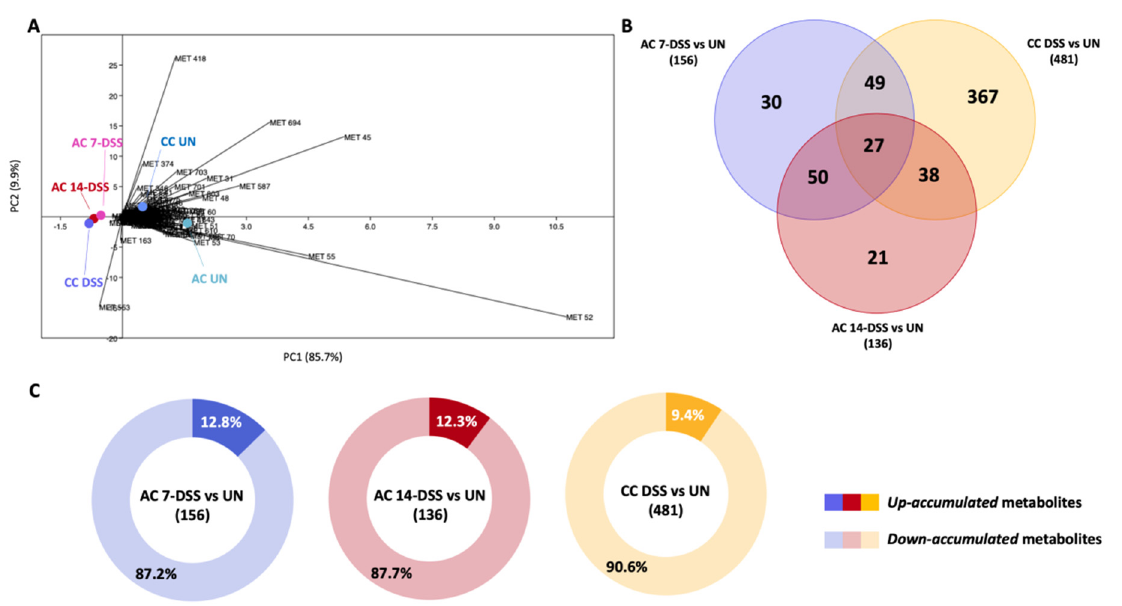
Figure 4. ( A ) Principal component analysis (PCA) of the profiling data from the fecal metabolome. ( B ) Venn diagram showing the common and unique metabolites biologically relevant in each comparison. ( C ) Circular diagram summarizing the percentage of up and down-regulated fecal metabolites found to be biologically relevant in each comparison. AC-7-DSS and AC-14-DSS: Mice with acute colitis at 7 or 14 days from the start of DSS treatment. CC DSS: chronically DSS-treated mice. UN: untreated mice. Table 1. List of differentially accumulated known metabolites in fecal samples of DSS acute and chronic induced colitis (AC-7, AC-14 and CC) vs. untreated